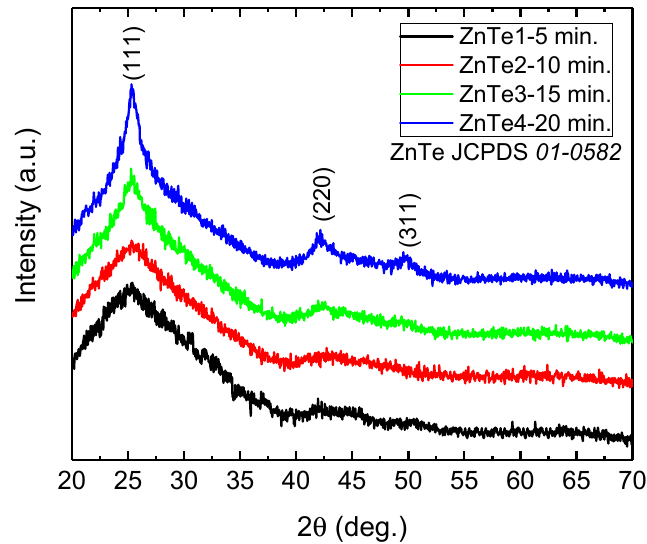
Figure 2. X-ray diffractograms of ZnTe films with different thicknesses.